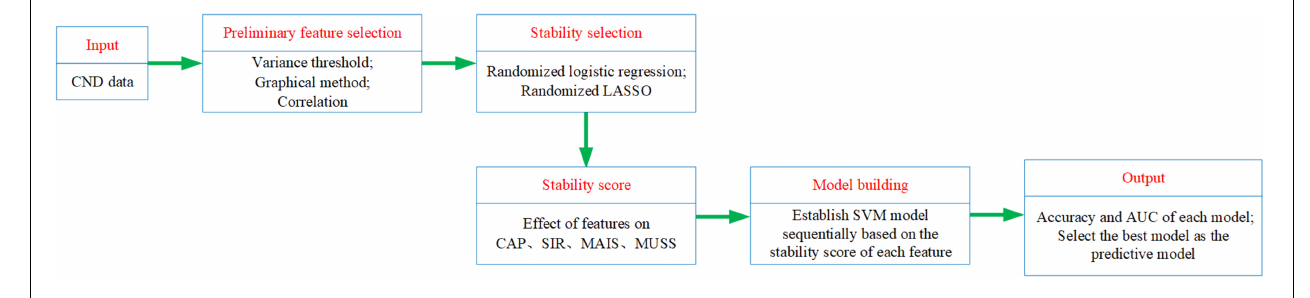
FIGURE 4 | Technology Roadmap.